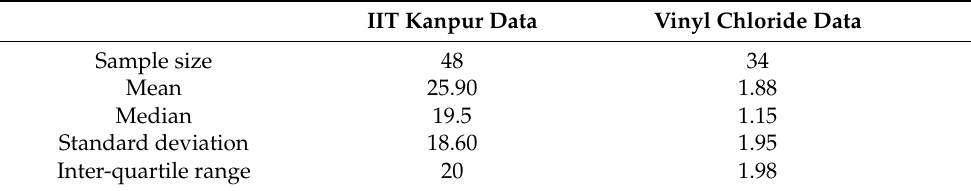
Table 5. Summary statistics for IIT Kanpur and vinyl chloride data sets.